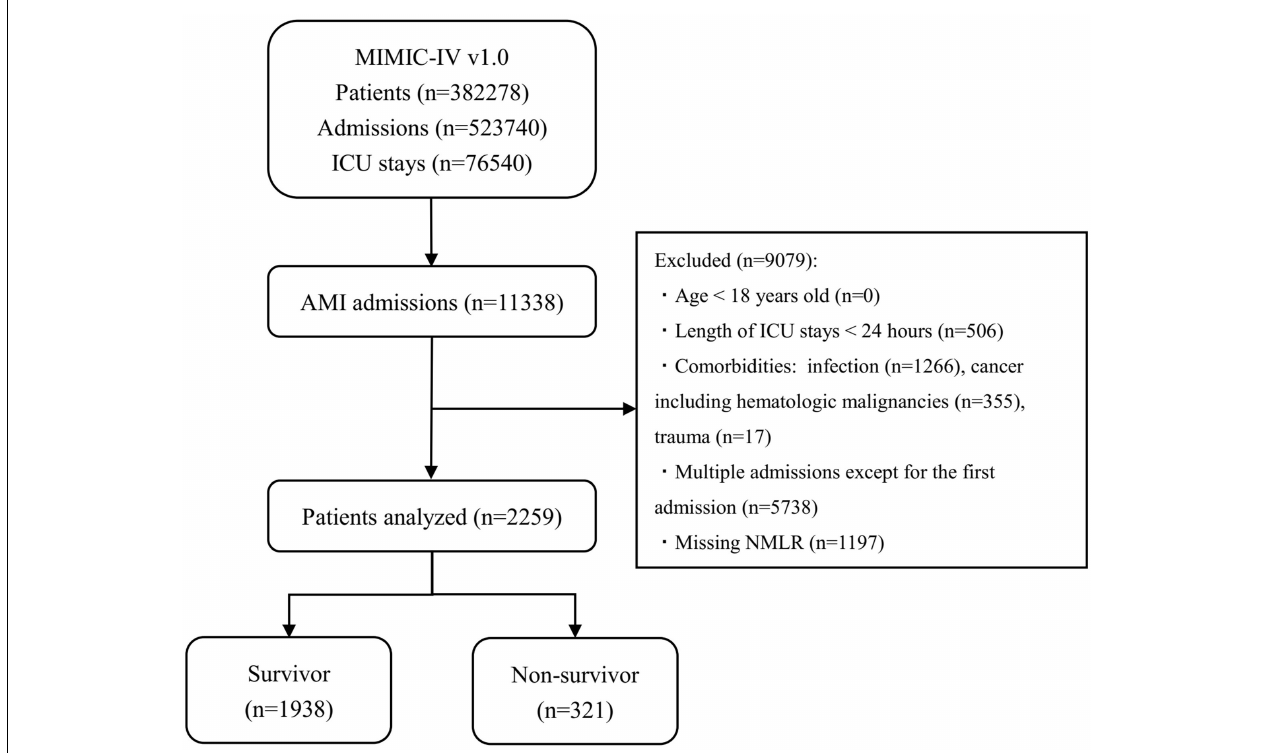
FIGURE 1 | Diagram of studied samples selection steps. The MIMIC-IV (version 1.0) database includes relatively comprehensive medical information of 3,82,278 patients, 5,23,740 admissions, and 76,540 ICU stays. In total, 11,338 admissions had a discharge diagnosis of AMI. The samples of patients who met the exclusion criteria in the figure were excluded ( n = 9,079). Eventually, 2,259 patients were included in this study, of whom 321 died. MIMIC, Medical Information Mart for Intensive Care; ICU, intensive care unit; AMI, acute myocardial infarction; NMLR, (neutrophil+monocyte)/lymphocyte